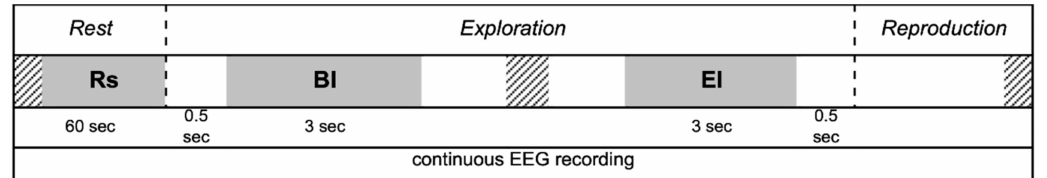
Figure 1. Time course of each single trial, including rest, exploration and reproduction phases during continuous EEG recording. Power spectrum analysis was performed on Rest (Rs), Begin Interval (BI) and End Interval